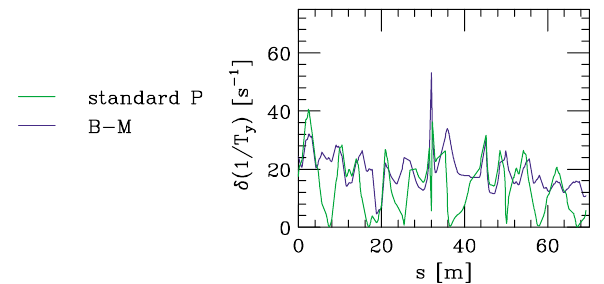
FIG. 1. (Color) Vertical steady-state (local) growth rate over 1 (cid:1) 2 the ATF for an example with vertical dispersion due to ran- dom errors. Given are results due to standard Piwinski (green curve) and Bjorken-Mtingwa (blue curve).